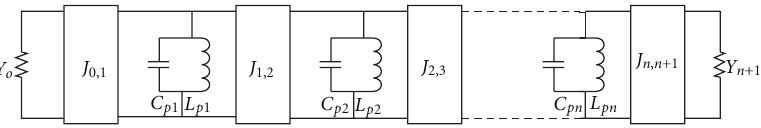
Figure 3: Bandpass filter network with admittance inverters and shunt LC